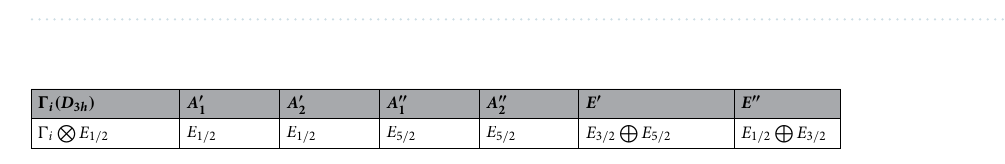
Table 2. Character table of the group D 3 h . Two common notations are used for the IRs of the single and double group.